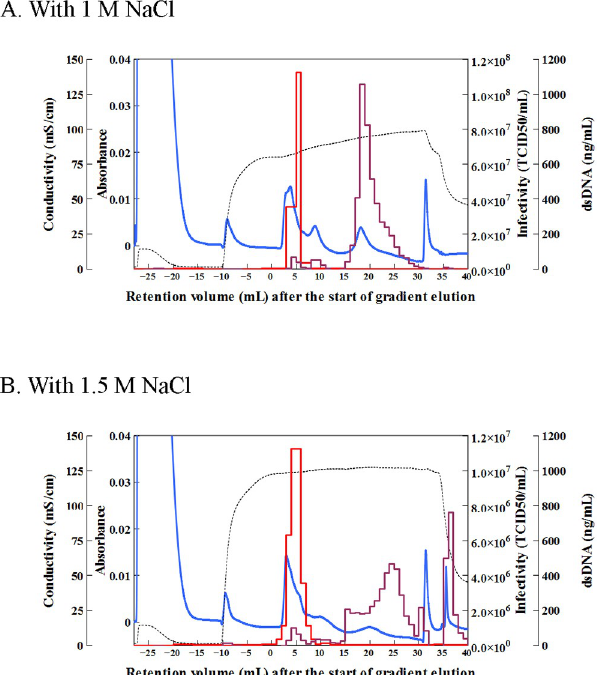
Fig 3. Chromatograms of Sabin type 2 virus-containing cell culture supernatant in the presence of NaCl. Separation was carried out in the presence of (A) 1 M NaCl and (B) 1.5 M NaCl under the following conditions: column, ceramic hydroxyapatite (CHAp); sample (volume), cell culture supernatant containing Sabin type 2 virus (5 mL); buffer pH, 7.2; column wash, 10 mM sodium phosphate buffer (NaPB; 9 mL); equilibration, 10 mM NaPB with NaCl (14 mL); elution, linear gradient from 10 mM to 600 mM NaPB with NaCl for 30 mL; wash after separation, 600 mM NaPB (10 mL). Lines are the same as in Fig 2. TCID 50 , median tissue culture infectious dose.